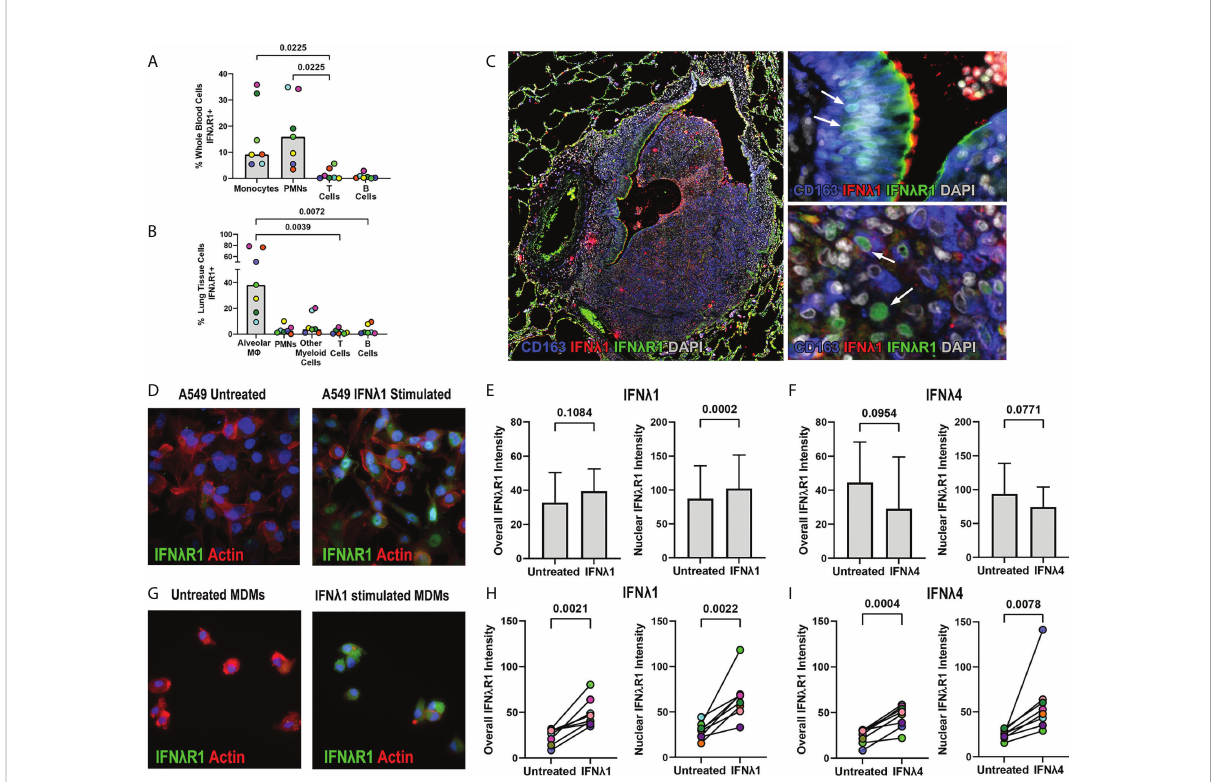
FIGURE 8 IFN l R1 localizes to the nuclei of macrophages and epithelial cells in granulomas. (A) IFN l R1 expression in different immune cell types from whole blood. (B) IFN l R1 expression in immune cells from macaque lung tissue (n=7). Friedman test was performed and pairwise groups compared using Dunn ’ s multiple comparisons test (Dunn ’ s adjusted p-values are reported). (C) Detection of IFN l R1 (green), IFN l 1 (red) and CD163 (blue) in a lung granuloma. Arrows indicate instances of IFN l R1 localized to nuclei. (D) A549 lung epithelial cells stained for IFN l R1 (green), actin (red) and DAPI (blue) after IFN l 1 stimulation. (E, F) Comparison of overall (left) and nuclear (right) IFN l R1 intensity in A549 epithelial cells, following IFN l 1 (E) and IFN l 4 (F) stimulations. Graphs show the mean value and standard deviation of 8 independent assays. Statistical comparisons by paired t test. (G) MDMs stained for IFN l R1 (green), actin (red) and DAPI (blue) after IFN l 1 stimulation. (H, I) Comparison of overall (left) and nuclear (right) IFN l R1 intensity in monocyte-derived macrophages, following IFN l 1 (H) and IFN l 4 (I) stimulations (n=8). Each point depicts the median IFN l R1 value in macrophages, with each marker ’ s color representing a different animal. Statistical comparisons by paired t test (H) and paired t test for overall IFN l R1 intensity or Wilcoxon matched-pairs signed rank test for nuclear IFN l 4 intensity (I)